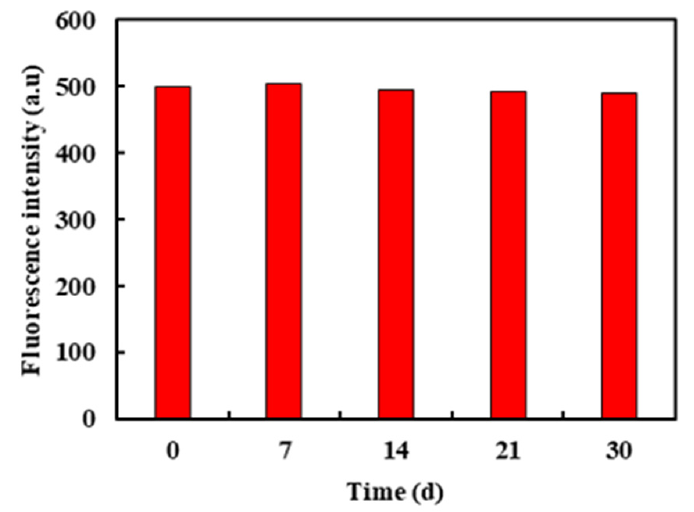
Figure 2. Storage stability of synthetic CDs.